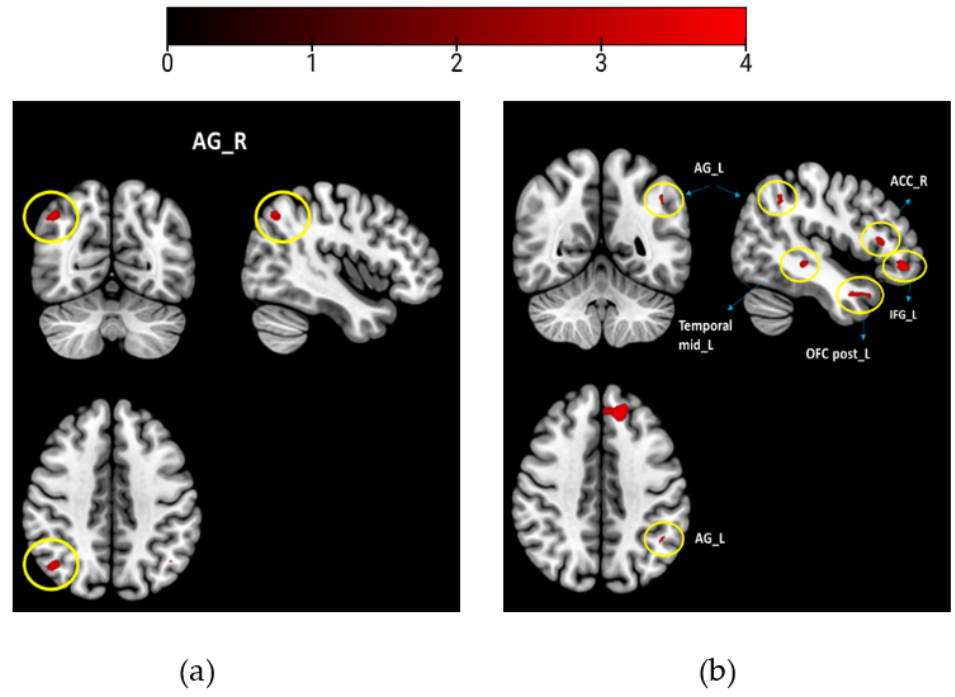
Figure 2. Between group results contrasting WB-associated odors > neutral odors ( a ) study 1; ( b ) study 2. Brain maps with thresholds set to p uncorrected < 0.001, and a cluster size of k > 10 voxels. Encircled are the activation regions labeled. Colorbar presents the t -value.